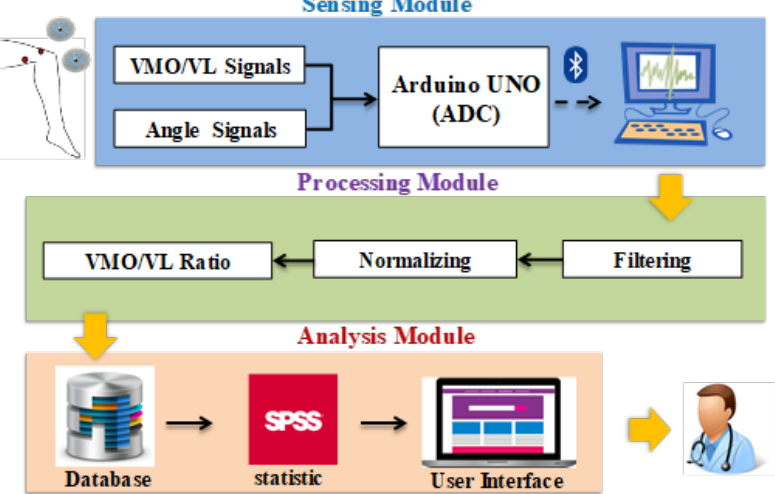
Figure 1. The vastus medialis obliquus training system architecture.